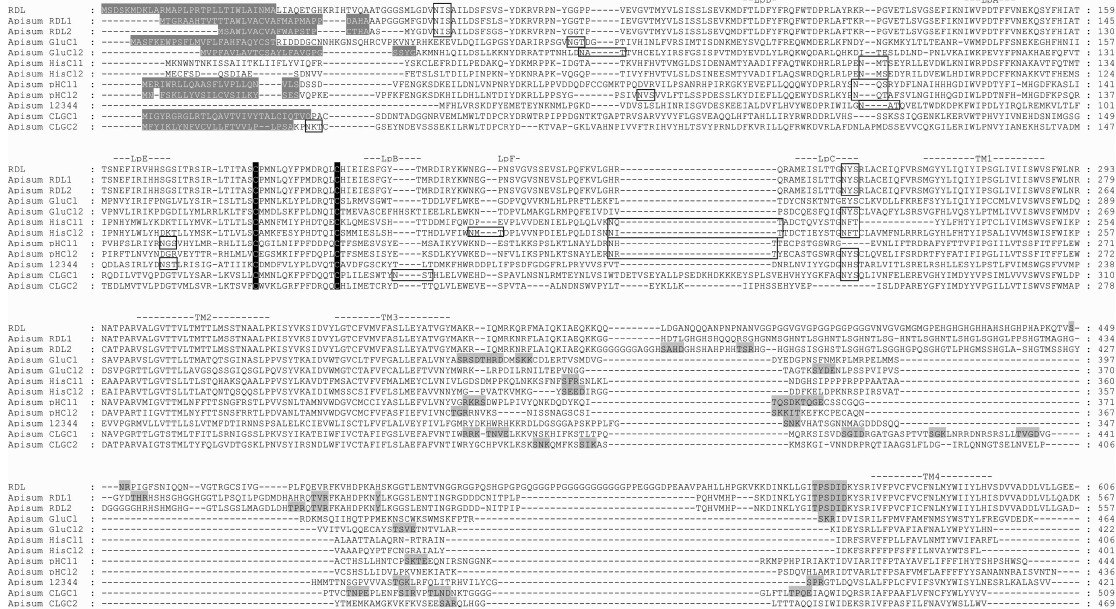
Figure 1. Protein sequence alignment of A. pisum cysLGIC subunits. D. melanogaster RDL bd (RDL) is included for comparison. N-terminal signal leader peptides are shown in gray shading and white text. Loops implicated in ligand binding (LpA–F) are indicated, as well as the four transmembrane (TM) domains. The two cysteines forming the cys-loop are highlighted in black shading, and putative N -glycosylation sites are boxed. Potential cAMP, PKC, CK2 and tyrosine kinase phosphorylation sites are shown in gray shading. The sequences presented in this alignment can be found in the Supplementary Material.